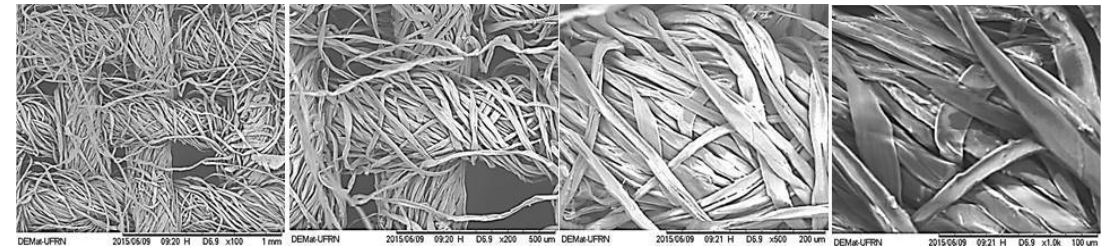
Figure 3. SEM images of raw fabric (magnification of 100x, 200x, 500x e 1000x)